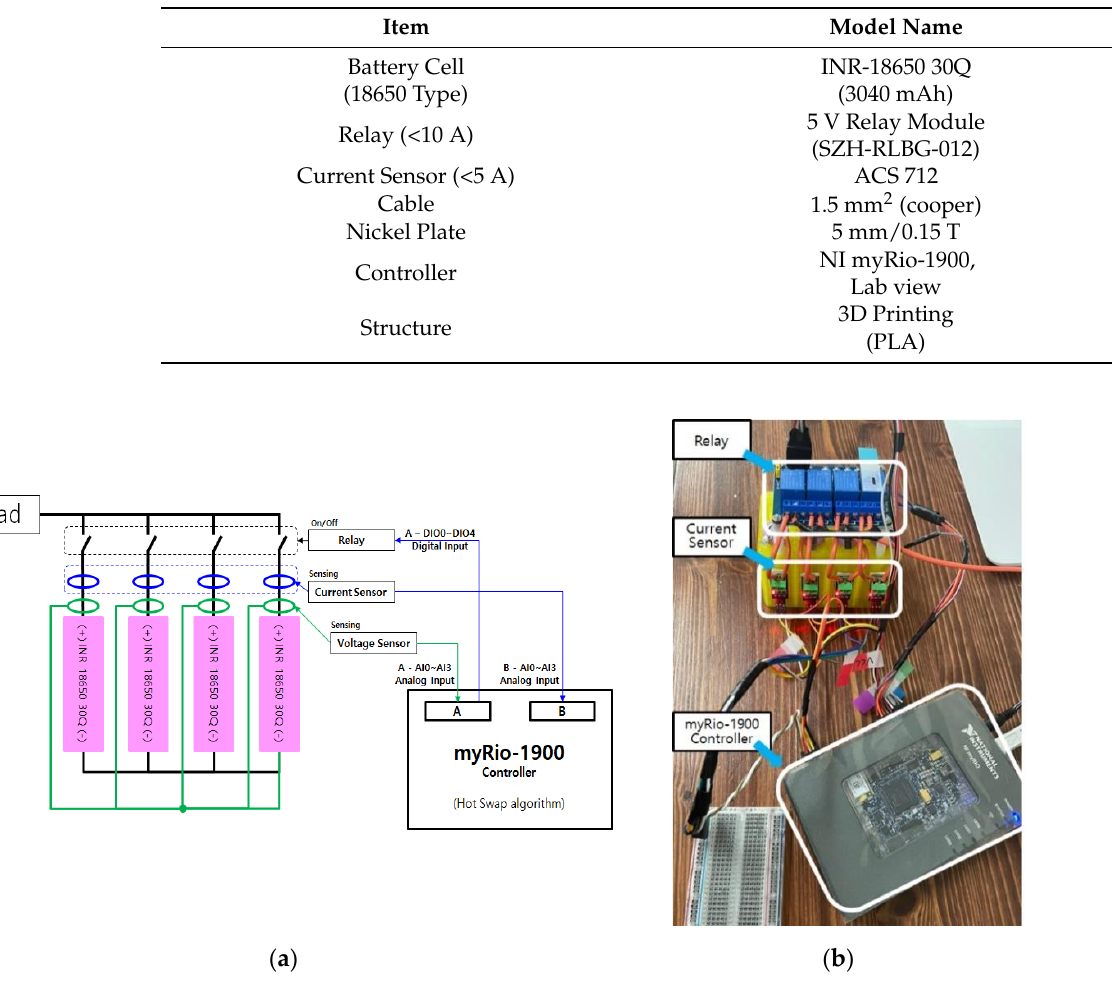
Figure 9. Configuration of the 1S4P battery pack for the experiment: ( a ) block diagram of the experimental construction; ( b ) hot-swap experiment and configuration of the measurement system. ( b ) hot-swap experiment and configuration of the measurement